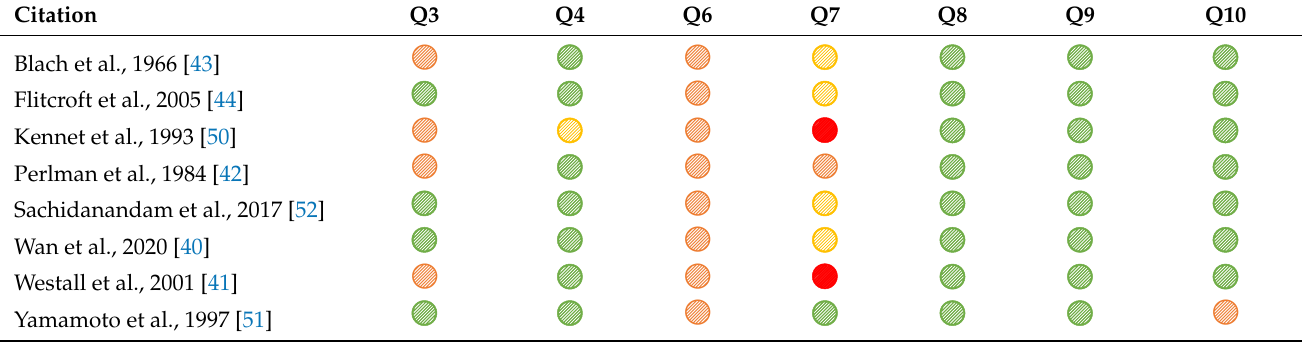
Table 5. OHAT risk of bias assessment of the included studies.